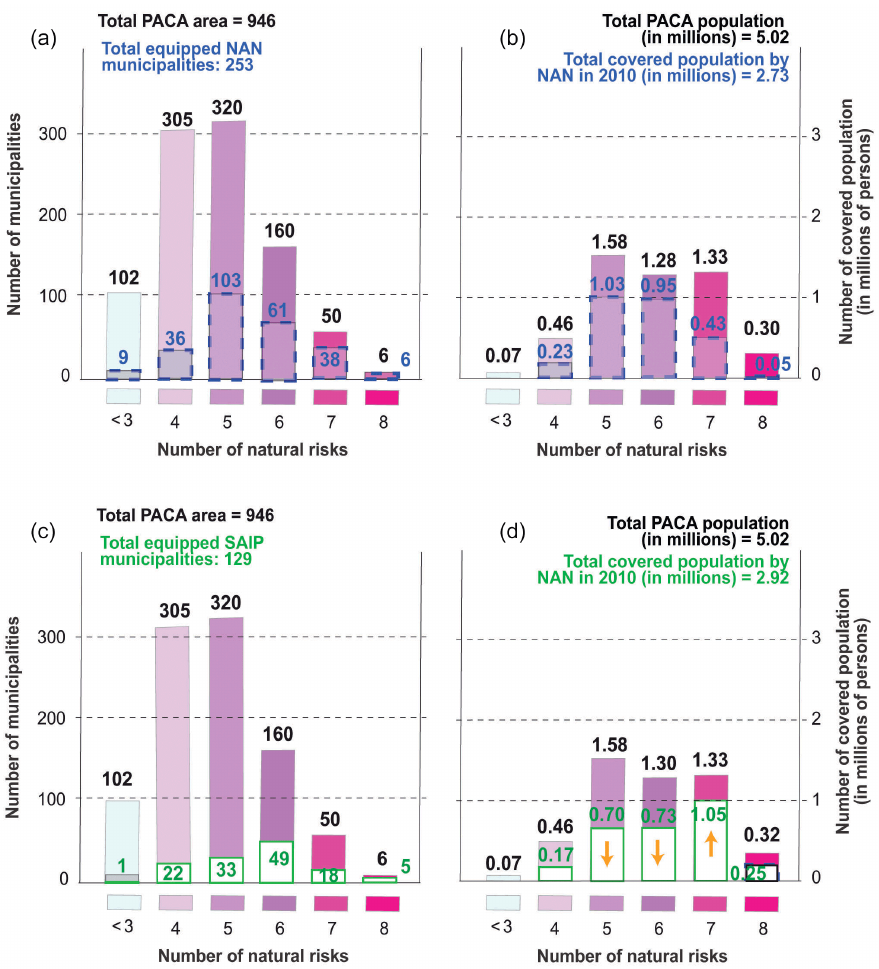
Figure 5. Covered municipalities and number of risks for the NAN (a) and the SAIP (b) sirens, according to the DDRM (2016) in the PACA